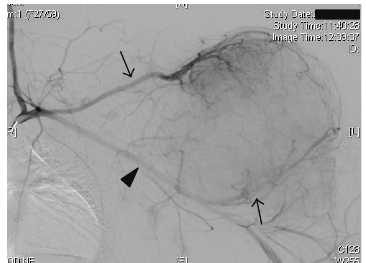
Figure 5: Preoperative angiography at the level of the left subclav- icular artery showing two enlarged arteries (arrows) reached upper and lower poles of the lesion, respectively. Note diameters of these feeding arteries compared with the axillar artery